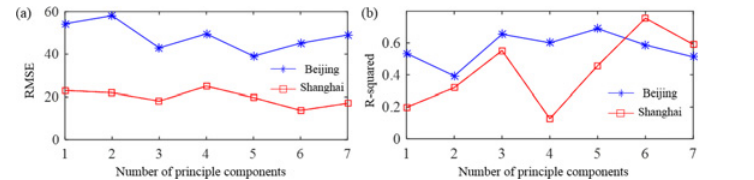
Fig 10. PCA-SVR results for Beijing and Shanghai ’ s dataset. (a) RMSE. (b) R-squared.